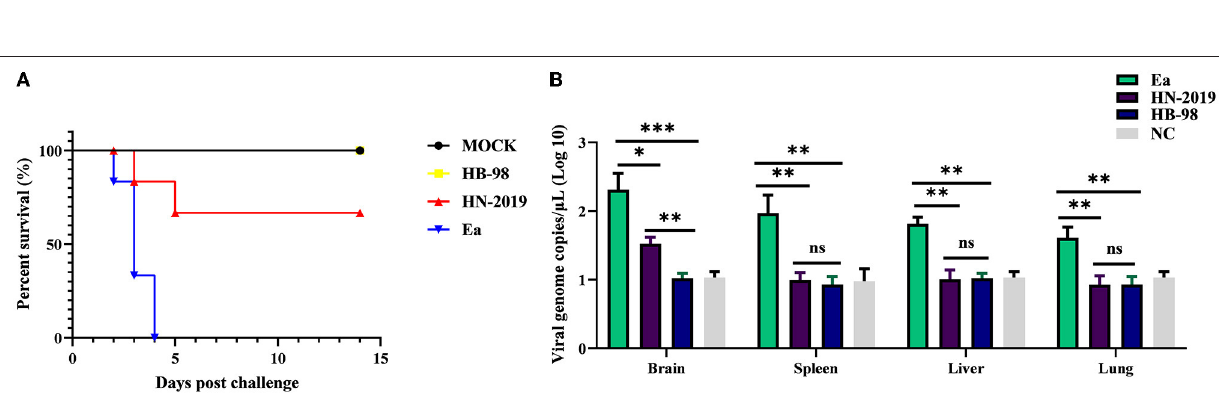
FIGURE 3 | Kaplan-Meier survival curves of mice challenged with 10 4 TCID 50 of HN-2019, Ea, or HB-98 vaccine strains (A) . Viral copies of brain, liver, lung, and spleen samples in each group ( n = 3) were determined by real-time PCR assays (B) . Significant differences were considered when P < 0.05 (*), P < 0.01 (**), and P < 0.001